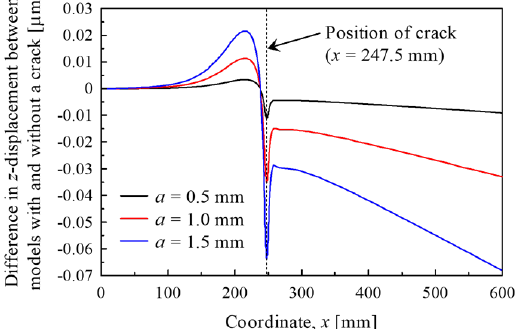
Figure 12. The z -displacement of the surface of Model 3D along trace line 1. The z -displacement implies the change in z -direction due to loading.